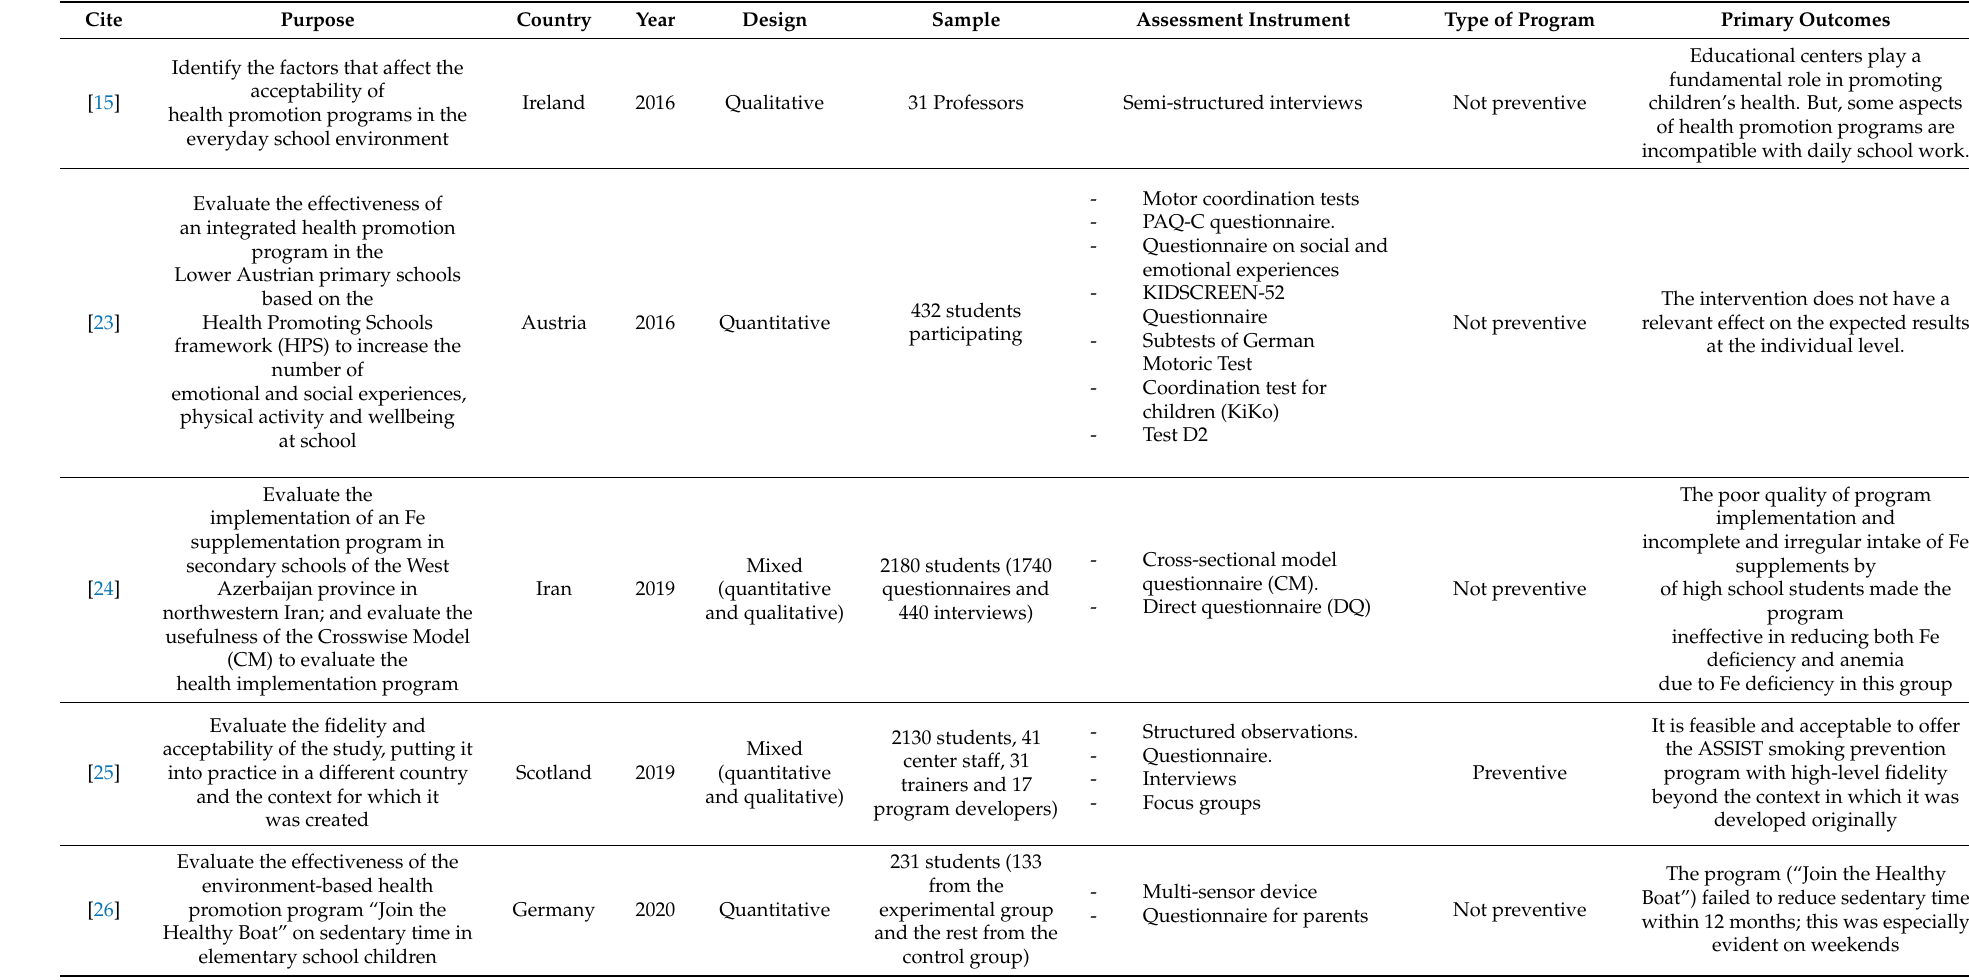
Table 2. Primary outcomes of the reviewed